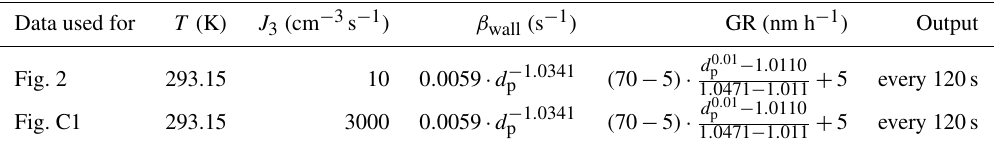
Table G1. Input data used to generate particle size distributions with the SALSA module. J 3 depicts the nucleation rate (i.e., the number concentration of particles being added to the 3nm sized particles per